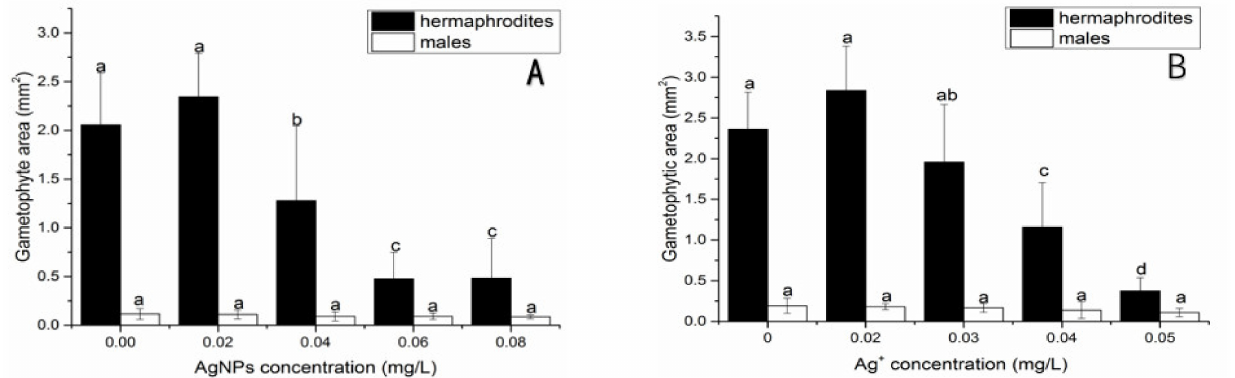
Figure 7. Effect of AgNPs ( A ) and Ag + ( B ) on the area of male gametophytes and hermaphrodites of Ceratopteris thalictroides after 21 d exposure. Data represent the mean ± SD ( n = 5). Data with different letters are significantly different among treatment within the same sexual gametophyte ( p <